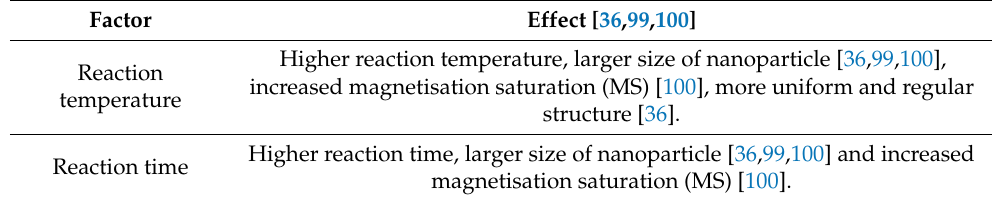
Table 4. Effect of temperature and reaction time in the manufacture of magnetite Fe 3 O 4